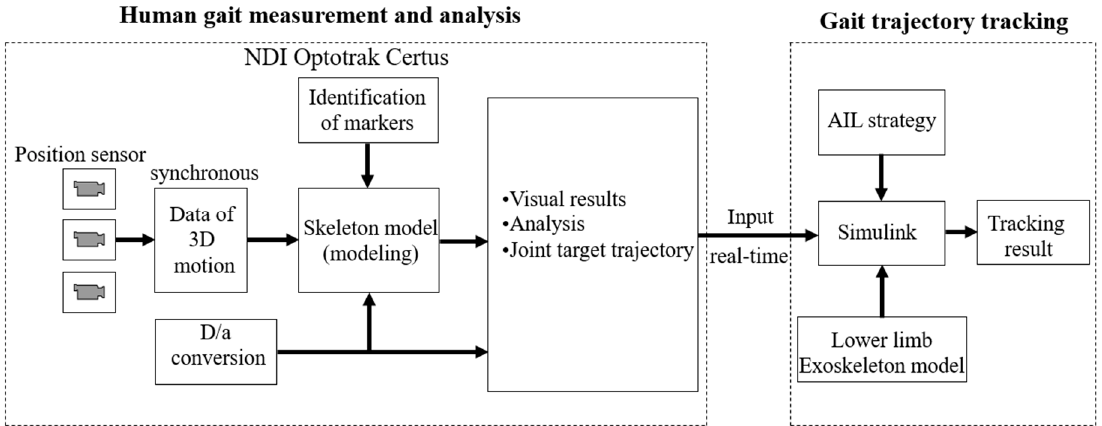
Figure 6. Flow chart of gait measurement and exoskeleton trajectory tracking.